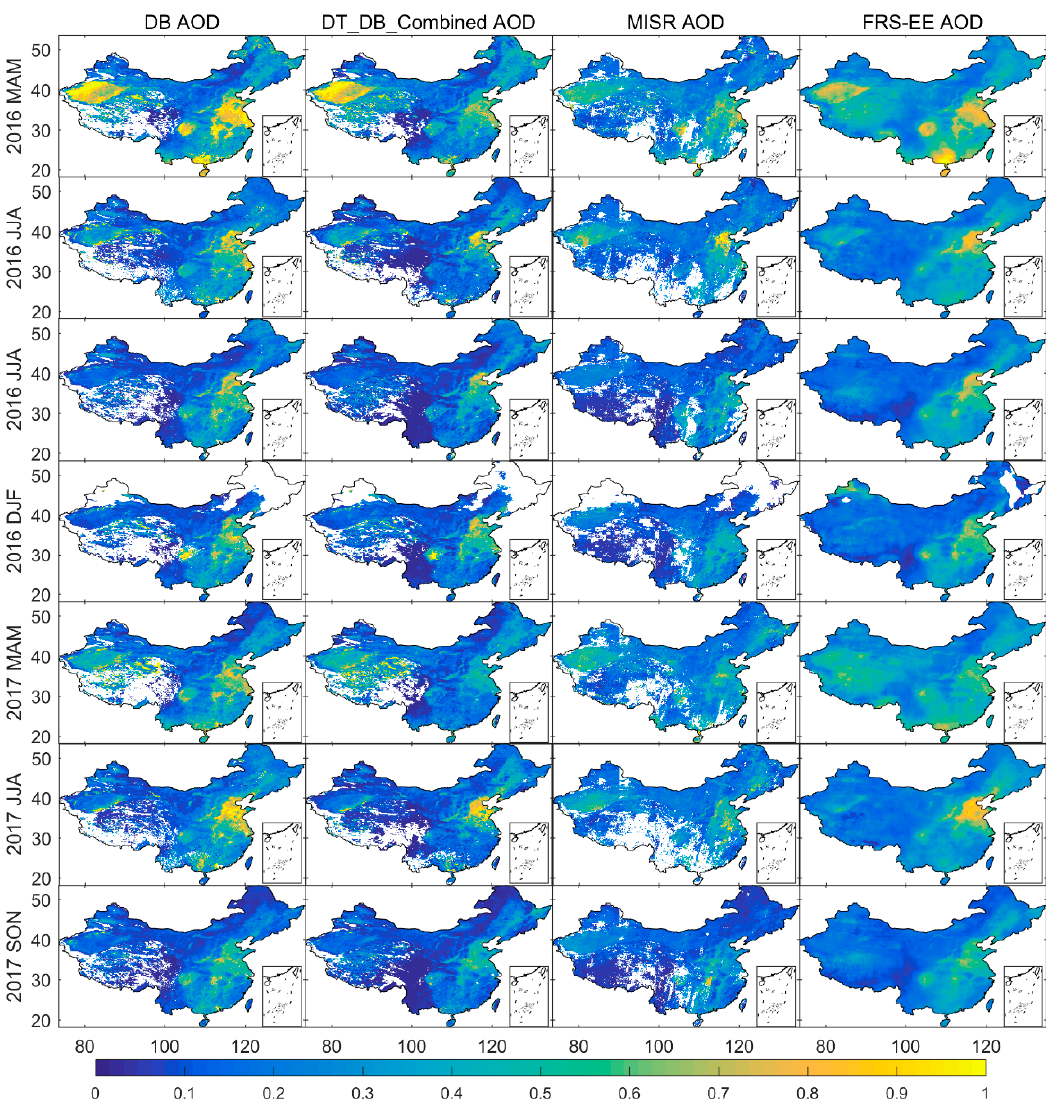
Figure 11. Season averaged AODs for original DB AOD, DT_DB_Combined AOD, MISR AOD, and FRS-EE fused AOD. MAM: March-April-May; JJA: June-July-August; SON: September-October-November; DJF: December-January-February.